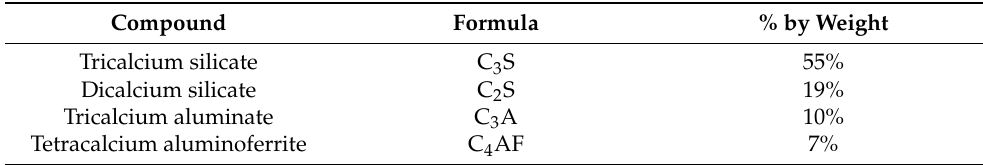
Table 1. Composition of Portland